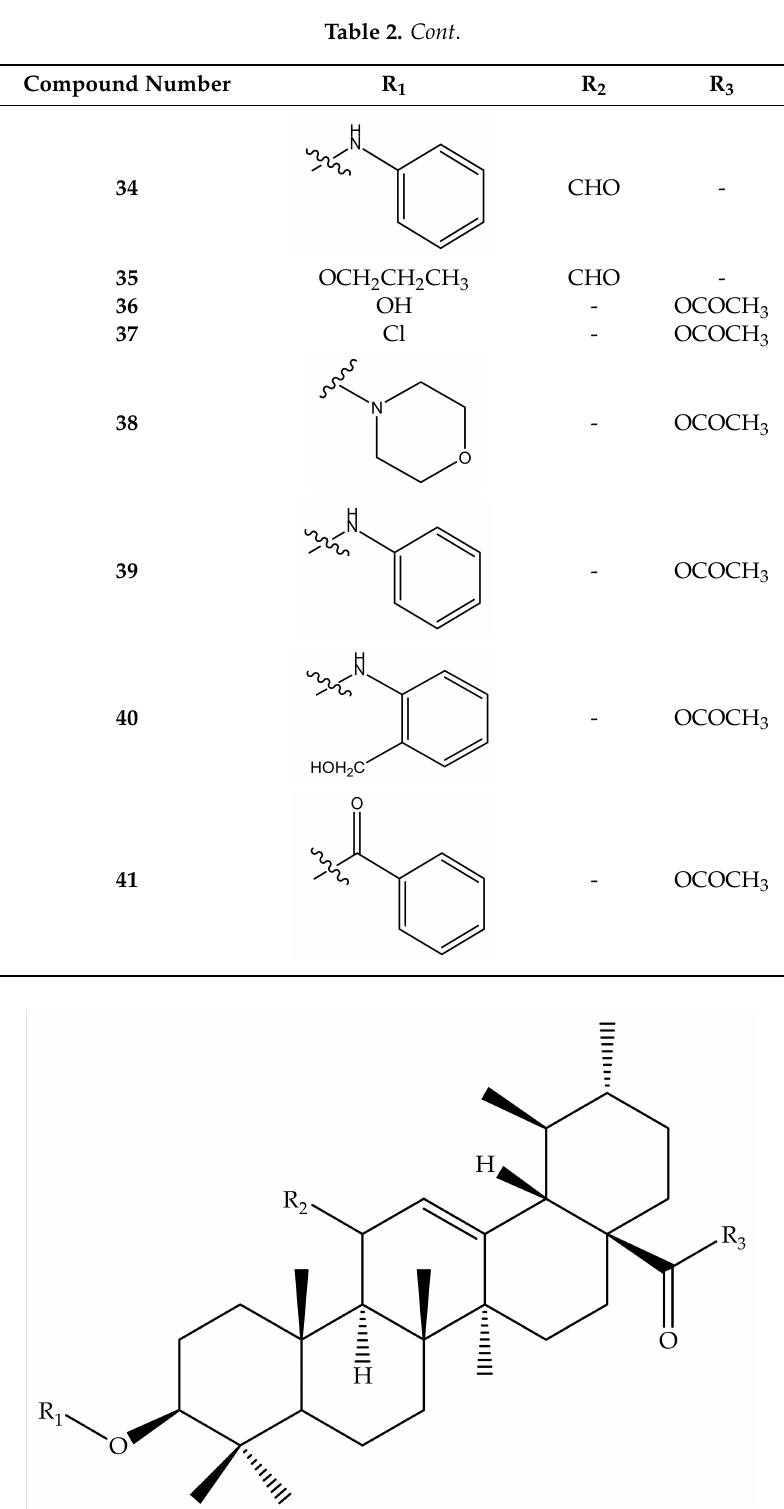
Figure 4. Some of UA derivatives. 1, 25–27; 1: R 1 = H; R 2 = H; R 3 = OH; 25: R 1 = OCCH 3 ; R 2 = H; R = OH; 26: R = OCCH = O; R = NHC 3 1 3 ; R 2 3 6 H 5 ; 27: R 1 NHCH 2 CO 2 CH 3